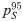
Dependence of λ
1 and Ca2+ spark probability on RyR2 cluster image interpretation.(A) Percent changes in spark probability and λ
1 for a collection of clusters reconstructed from STED images after raising the fluorescence intensity threshold from the 95th percentile (pS95, λ195) to the 98th percentile (pS98, λ198). (B) Relationship between λ
1 and p
S when cluster structures are determined at the 95th (black) and 98th (red) percentiles.